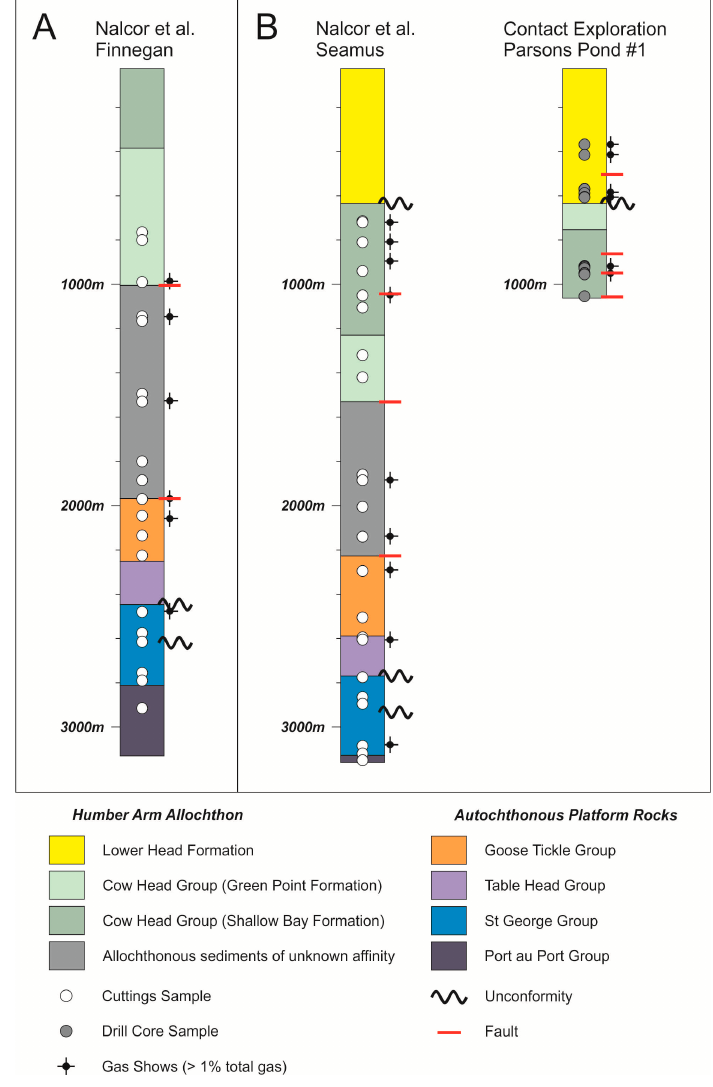
Figure 3. Simplified stratigraphic logs for exploration wells in the Parsons Pond area, showing the location of drillcore and cuttings samples used in this study (location of wells shown in Figure 1). ( A ) Stratigraphic log for Nalcor et al. Finnegan (northern well); ( B ) Stratigraphic logs for Nalcor et al. Seamus and Parsons Pond #1 (southern wells). Stratigraphy adapted from [35–37].